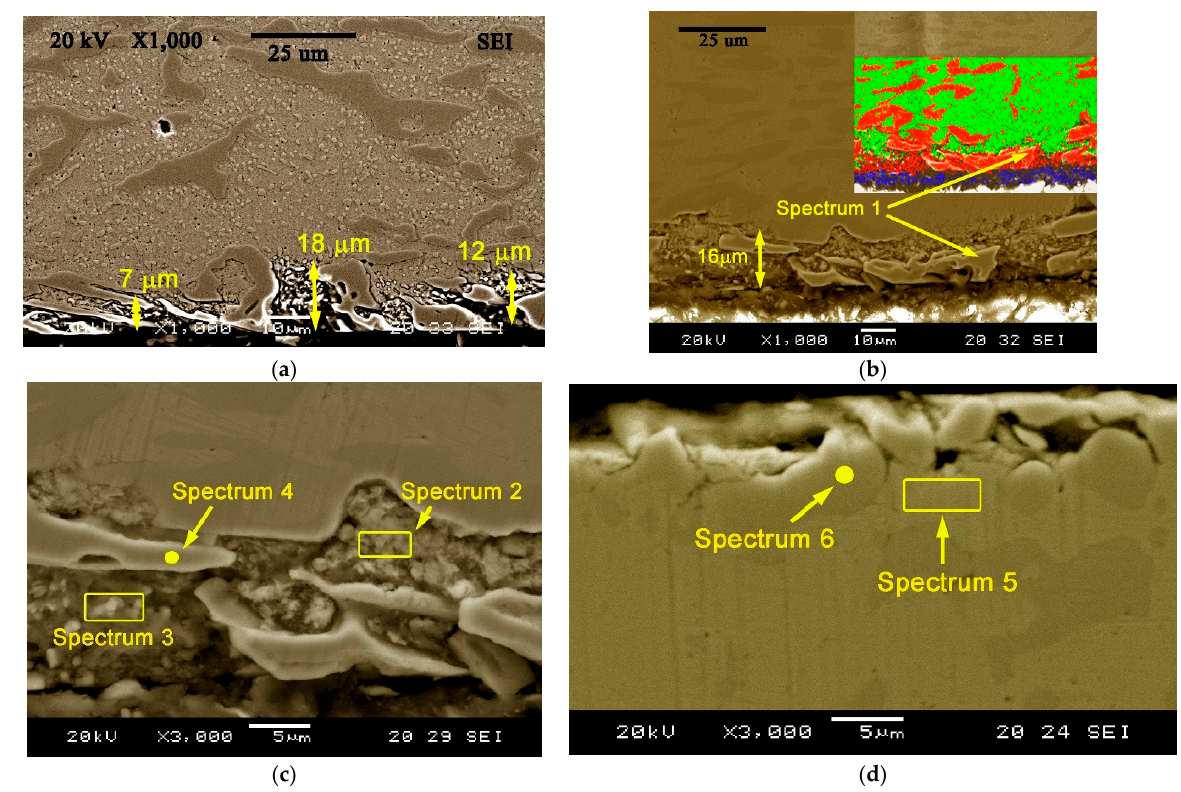
Figure 5. Thickness of the nitrided layer (SEM). ( a ) Experiment 5. Magnification of 1000 × ; ( b ) Mapping of elements by means of energy dispersive X-ray (EDX) microanalysis, corresponding to experiment 5. Blue: N; Red: Cr; Green Fe. Magnification of 1000 × ; ( c ) EDX analysis of the nitrided layer corresponding to experiment 7. Magnification of 3000 × ; ( b ) EDX analysis of the nitrided layer corresponding to experiment 8. Magnification of 3000 × .